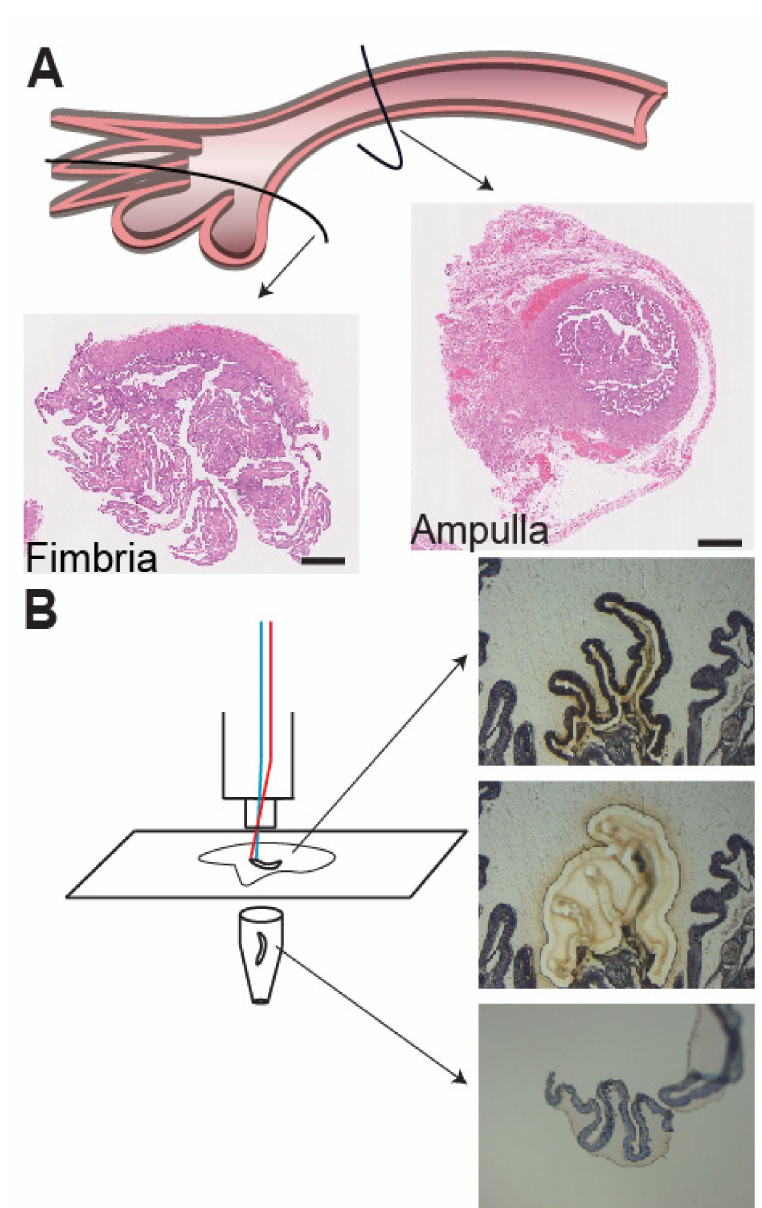
Figure 1. Preparation of fallopian tube epithelia (FTE) tissue for staining and RNA isolation using the SEE-FIM protocol. ( A ) H&E staining of cryopreserved fimbria and ampulla from fallopian tubes. Cases included 13 fimbriae and 12 ampullae from woman at no known risk of ovarian cancer. Six cases were from the luteal phase and seven cases from the follicular phase. Image was hand-drawn by S.G. ( B ) Cryopreserved fimbria and ampulla from fallopian tubes were sectioned and underwent laser-capture micro-dissection followed by RNA isolation. Cases were matched by ovarian cycle status and were all obtained from pre-menopausal women. Scale bar: 5